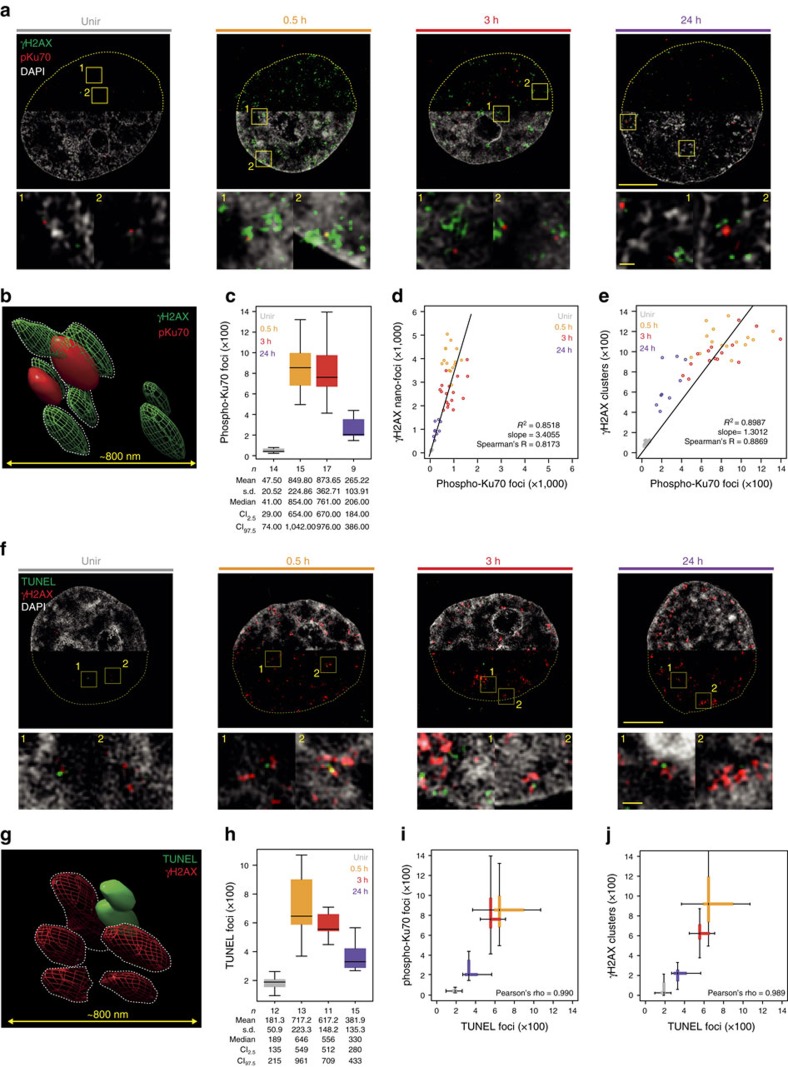
Single phospho-Ku70- or TUNEL-labelled DNA DSBs are embedded in γH2AX clusters.(a) Exemplary 3D-SIM images of γH2AX and phospho-ku70 immunofluorescence before and during DDR. Shown are the mid-nuclear section (top) and enlarged views from the yellow frames (bottom). (b) 3D rendering of γH2AX and phospho-Ku70 immunostaining, 24 h after IR. (c) Phospho-Ku70 foci number distributions before and during DDR, from 3D-SIM images (one-way ANOVA with Dunnett's correction: P<10−3). Scatter plots of phospho-Ku70 foci and γH2AX nano-foci (d) or γH2AX clusters (e). Each dot represents a single-cell nucleus. (f) Exemplary 3D-SIM images of γH2AX and TUNEL immunofluorescence before and during DDR. Shown are the mid-nuclear section (top) and enlarged views from the yellow frames (bottom). (g) 3D rendering of γH2AX and TUNEL immunostaining, 24 h after IR. (h) TUNEL foci number distributions before and during DDR, from 3D-SIM images (one-way ANOVA with Dunnett's correction: P<10−3). Comparison between TUNEL and phospho-Ku70 (i) or γH2AX clusters (j) distributions, before and during DDR (P<10−3). Scale bars, 5 μm and 500 nm for main micrographs and magnified regions, respectively. All boxes and whiskers are as in Fig. 1. n: number of analysed cells. Results are from two independent experiments.